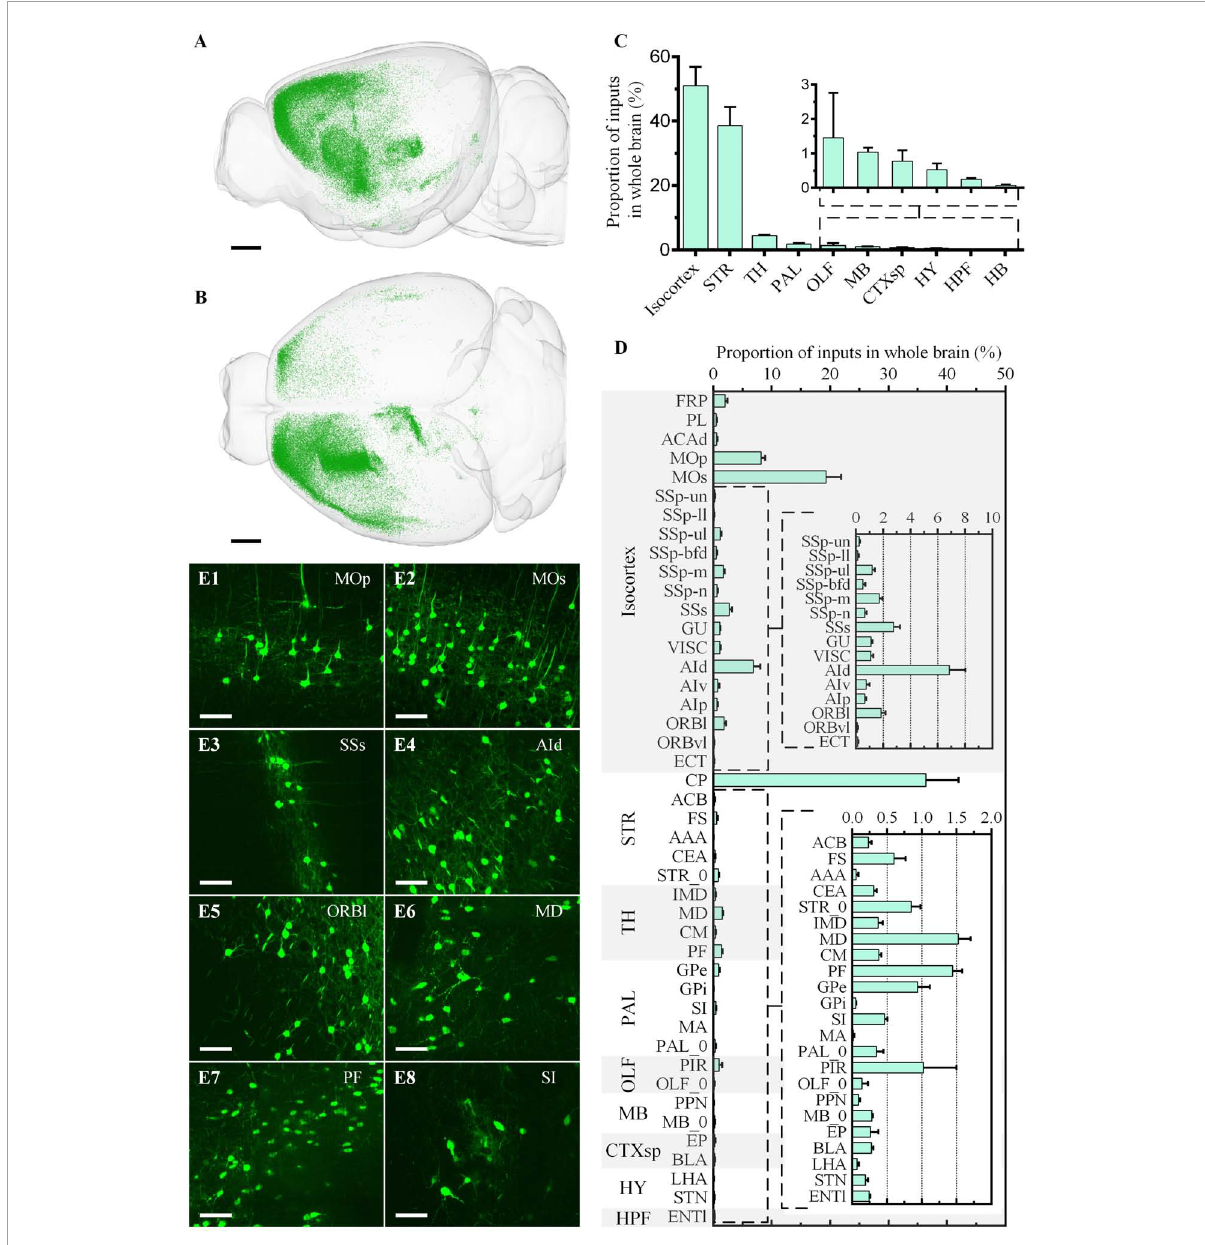
FIGURE6 Whole-brain quantitative statistics of the inputs of the ventral CP in the green channel. (A,B) Whole-brain distribution of input neurons in the sagittal view (A) and horizontal view (B) . (C,D) The proportion of inputs in the brain regions (C) and the brain sub-regions (D) . Data is shown as mean ± s.e.m ( n = 4 mice). (E1–E8) Signal distribution in MOp, MOs, SSs, AId, ORBl, MD, PF, and SI, respectively. The projection thickness of the images: (E1–E8) 10 µ m. Scale bars: (A,B) 1 mm, and (E1–E8) 50 µ m.